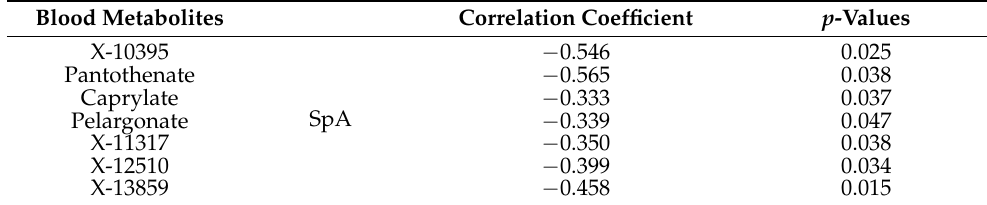
Table 1. Genetic correlation between human blood metabolites and SpA. Blood